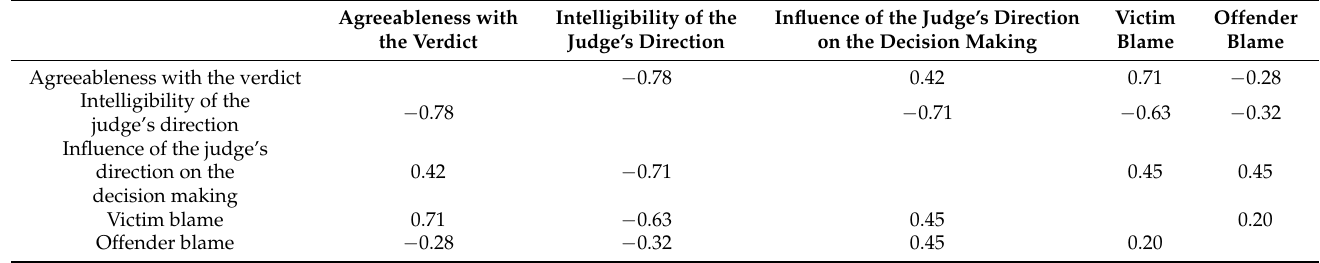
Table 3. Correlation coefficients between the variables for the control